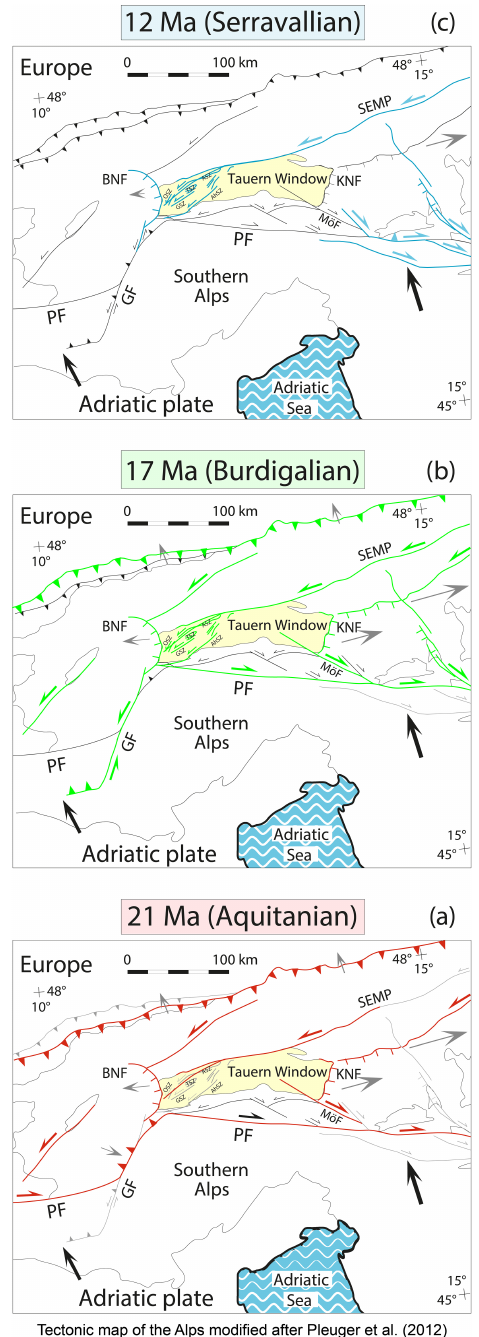
Figure 8. Tectonic map of the Alps based on Pleuger et al. (2012) showing active Cenozoic faults at ∼ 21 (in red), 17 (in green) and 12Ma (in blue), respectively. Note that after 17Ma the Giudicarie fault (GF) becomes active and hence the Periadriatic fault (PF) and the Mölltal fault (MöF, dextral fault at the southeastern corner of the TW) become inactive. Sinistral strike-slip faulting starts at ∼ 19Ma and is affecting the western and central parts of the TW until at least 7Ma. Future active faults are depicted in grey and inactive faults in